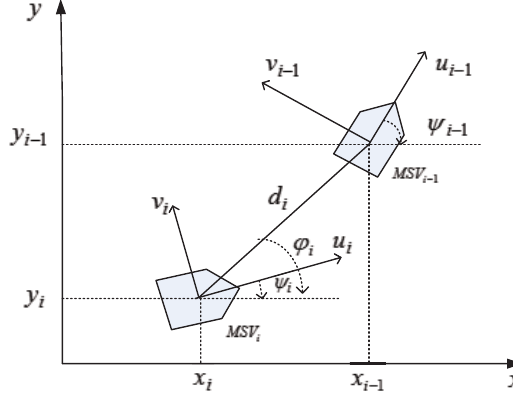
Figure 2. Unmanned surface vehicle (USV) formation